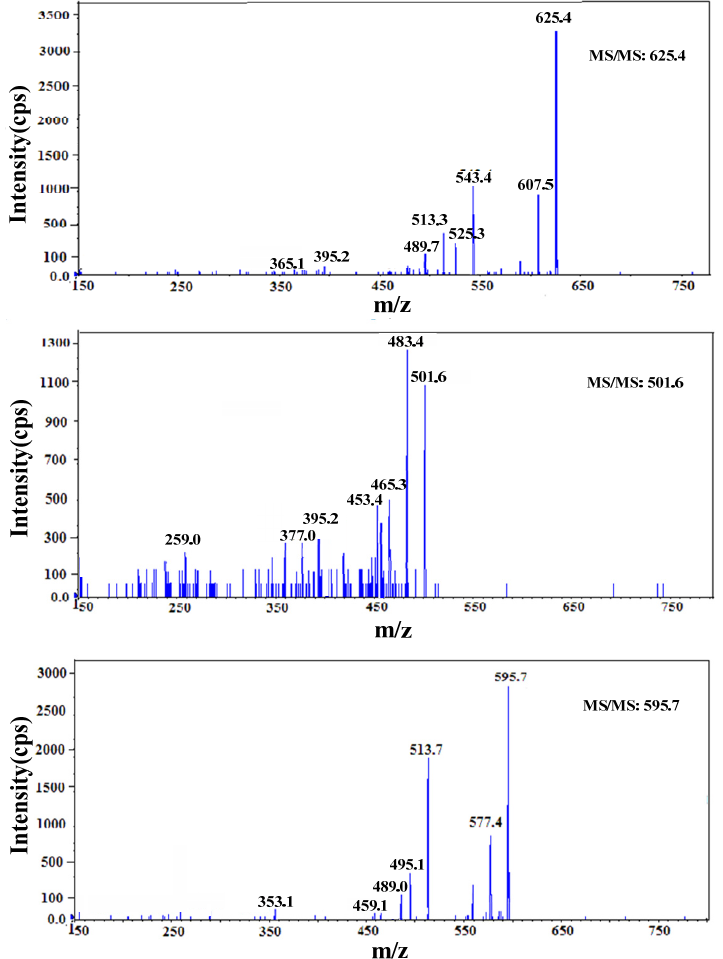
Figure 5. Secondary mass spectra of parent ions m/z 625.4, m/z 501.6 and m/z 595.7